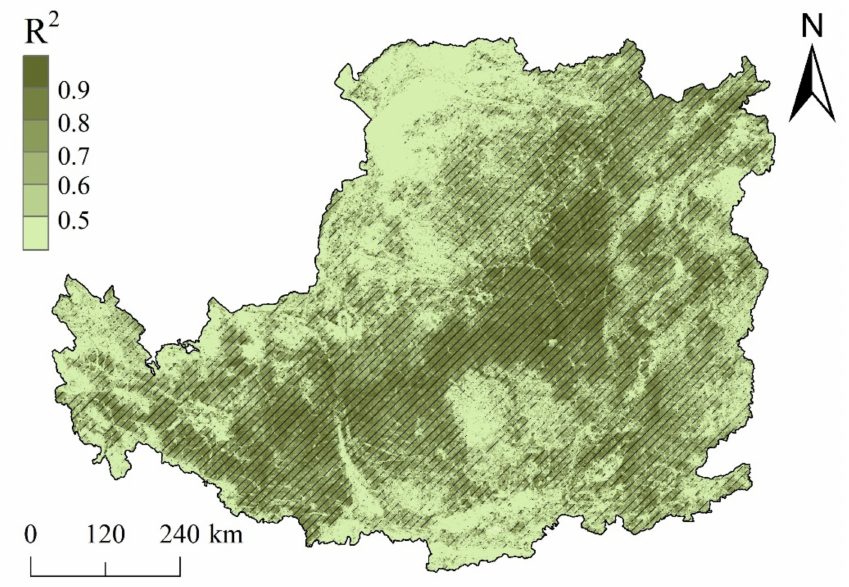
Figure 11. R 2 values and significance levels ( p < 0.05) of the multiple regression